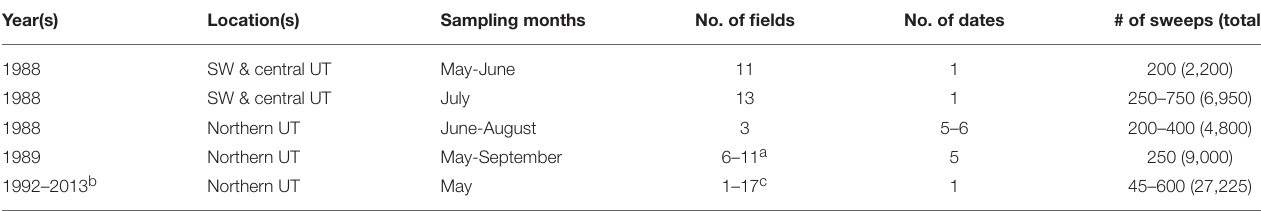
TABLE 1 | Summary of sweep sampling conducted in alfalfa fields in 1988–1989 and during 1992–2013 b , from which the numbers of individuals of adult lady beetles ( Coccinella spp.) collected were determined.